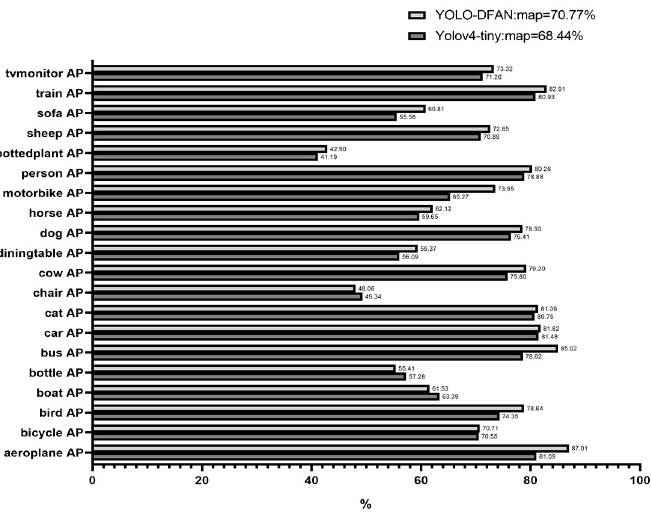
Figure 8. Results for YOLOv4-tiny and YOLO-DFAN on the Pascal voc07+12 dataset.